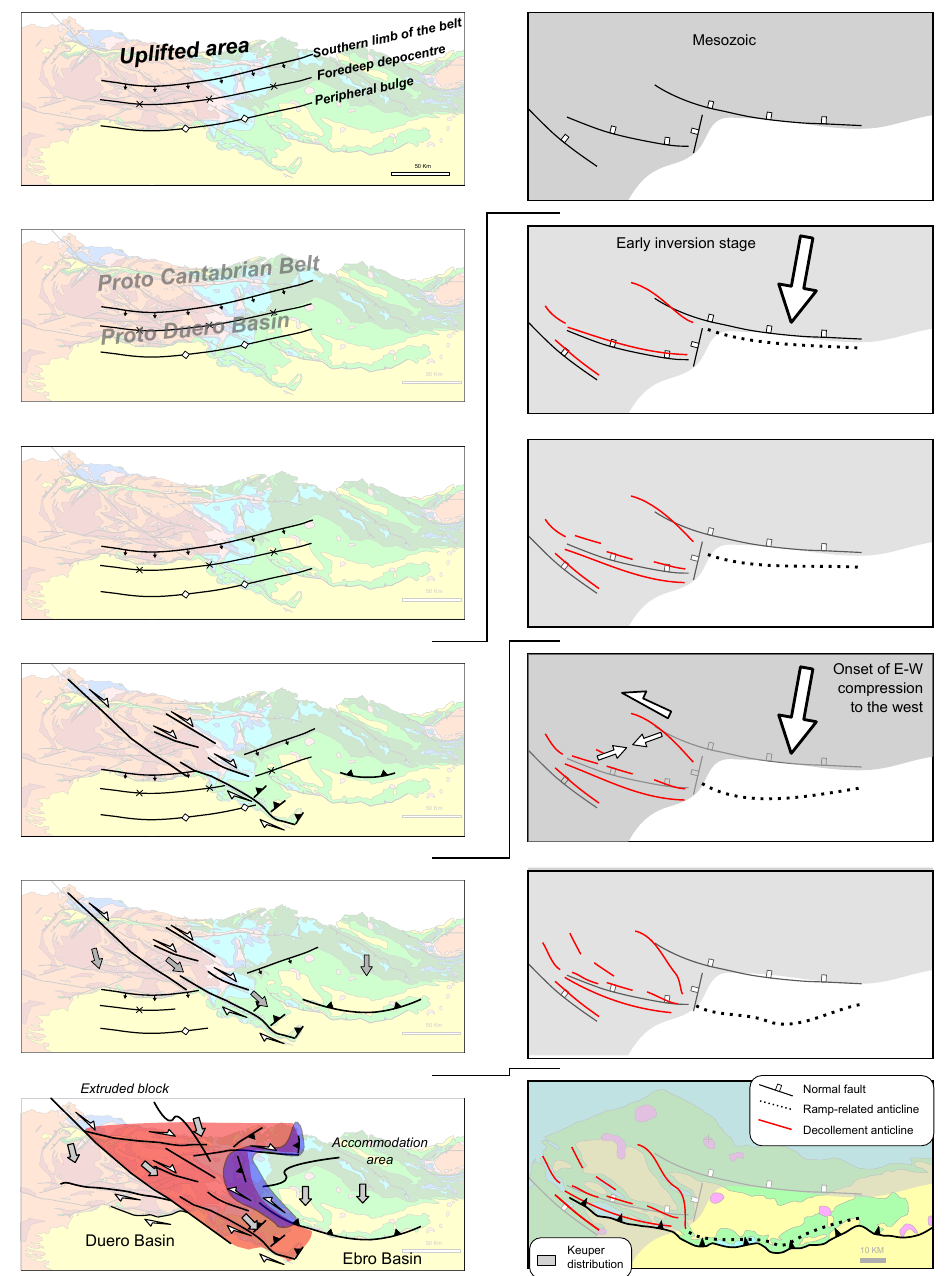
Fig. 19. Schematic Cenozoic evolution of the area (left), with detail of the Sierra de Cantabria Thrust Sheet (right).